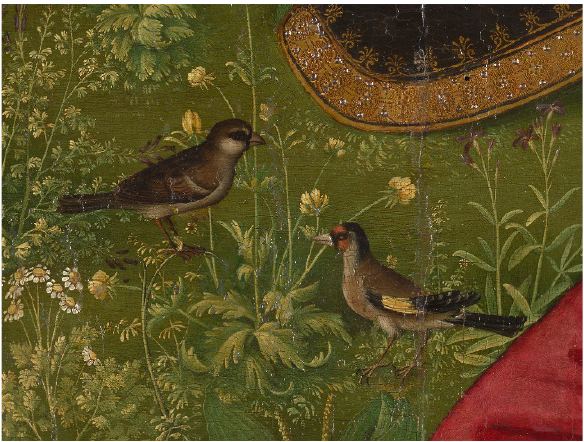
Figure 14 . Detail of the Borja family coat of arms.